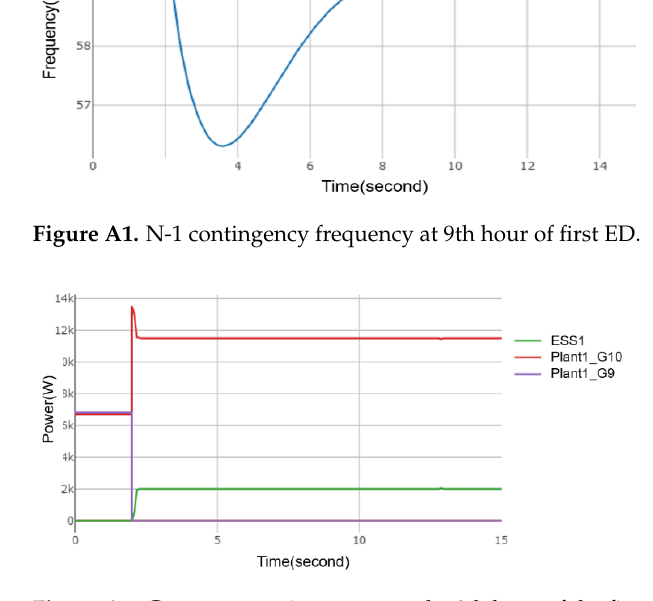
Figure A2. Generators active power at the 9th hour of the first ED.